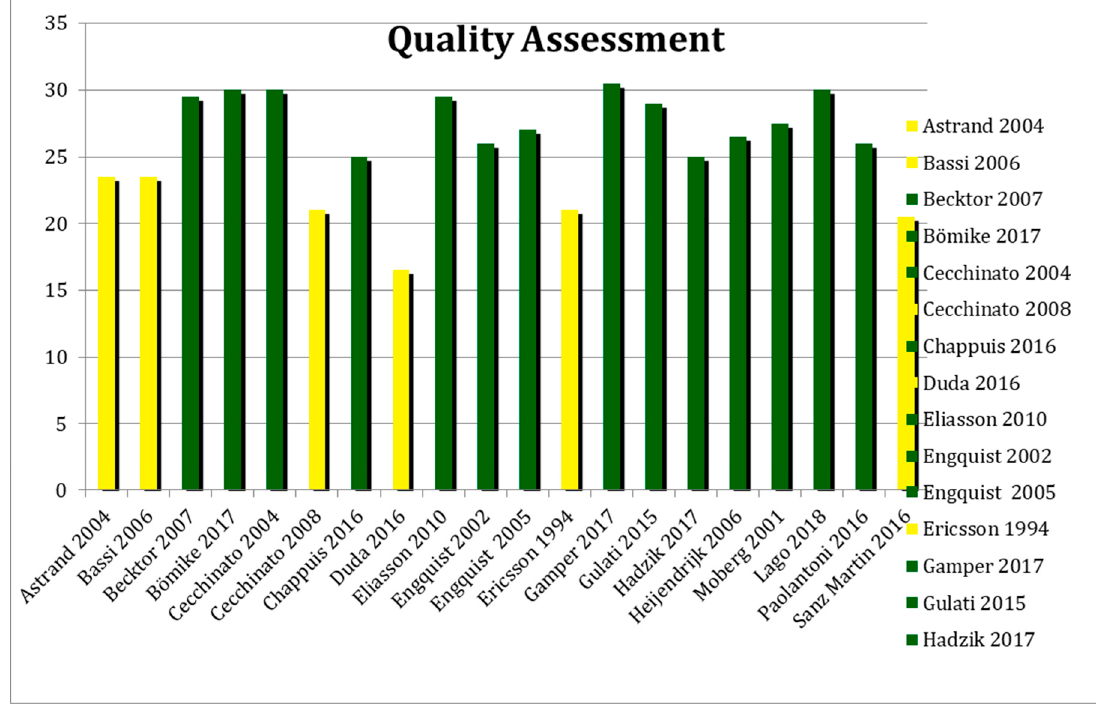
Figure 2. Quality assessment of the studies.